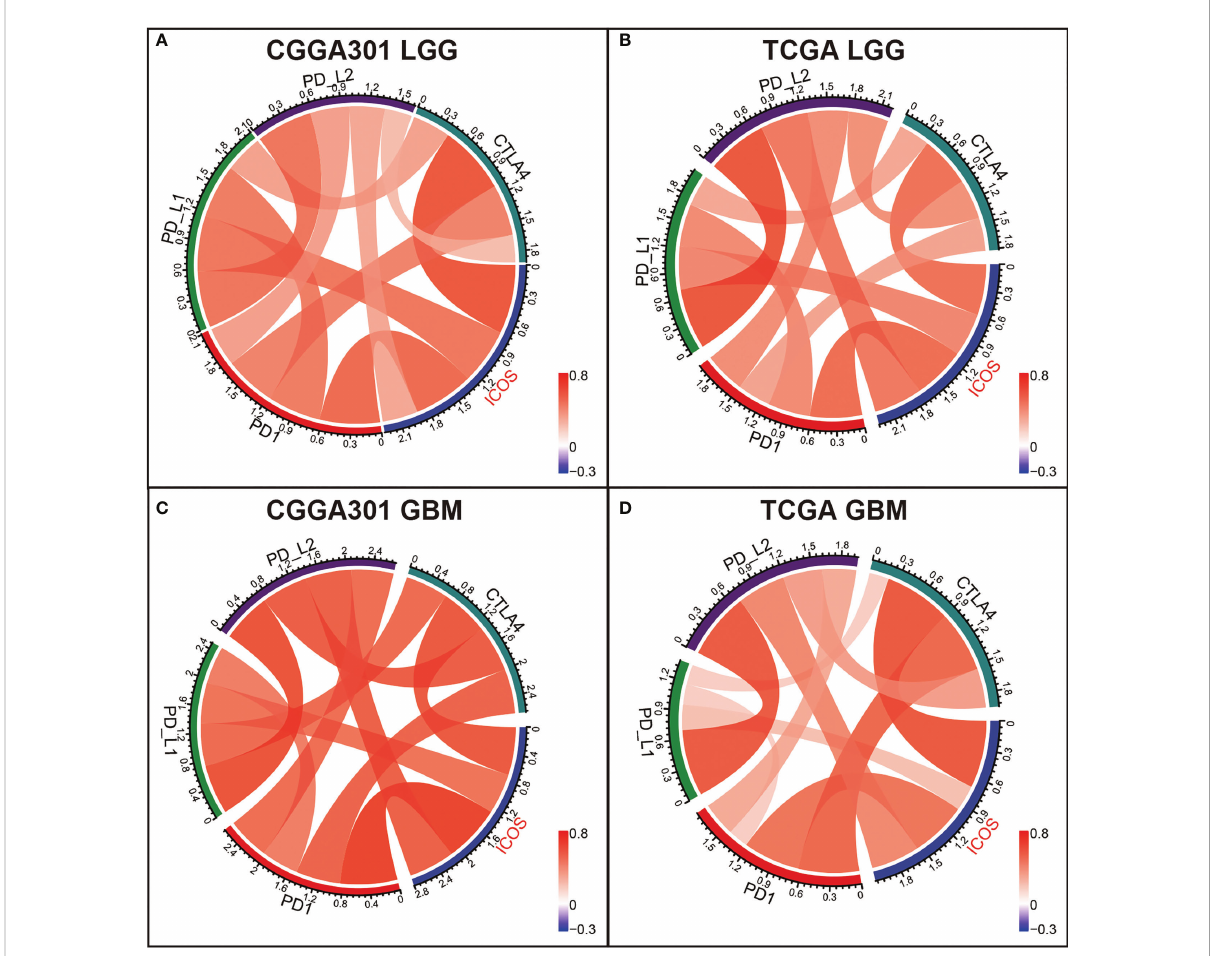
FIGURE 5 Correlation analysis between ICOS and canonical immune checkpoints in CGGA301 and TCGA datasets. (A) Correlation analysis in the CGGA301 dataset. (B) Correlation analysis in TCGA lower-grade glioma. (C) Correlation analysis in CGGA301 glioblastoma. (D) Correlation analysis in TCGA